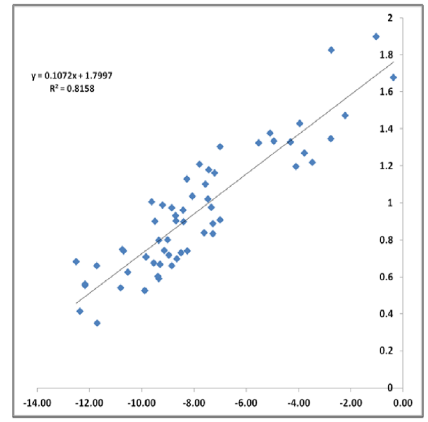
Figure 2. Roughness model by dual polarimetric approach with θ high data RMS height (Y axis) against σ HV - σ HH (X axis)